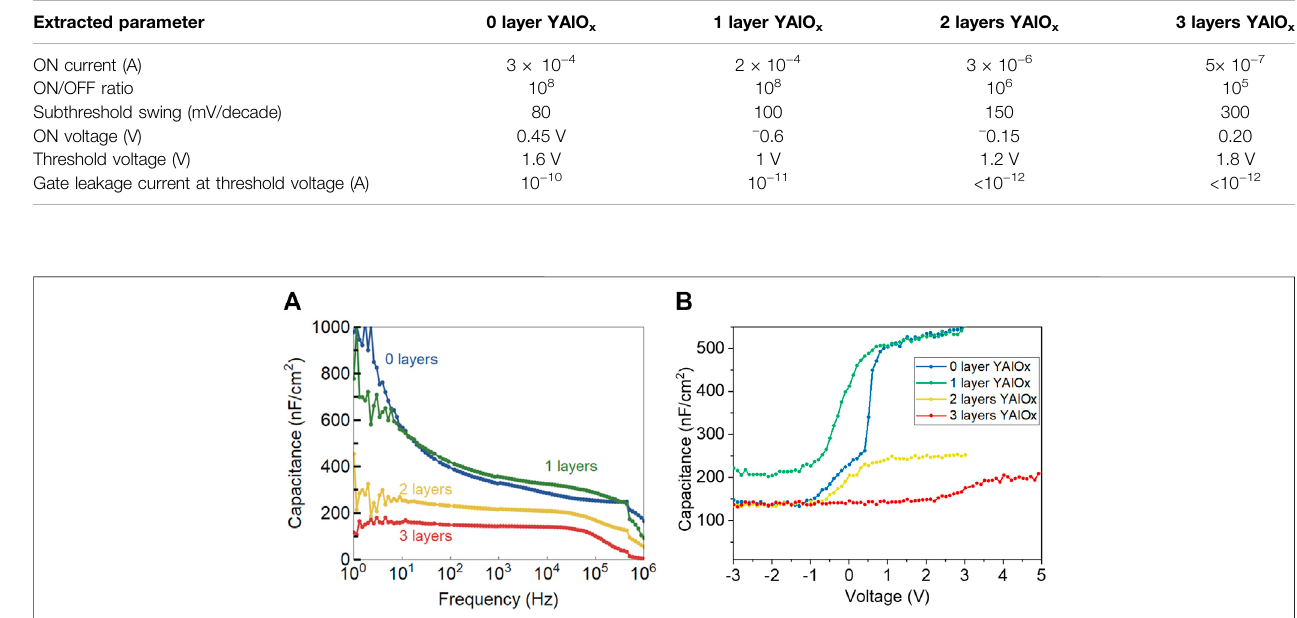
FIGURE 3 | (A) Frequency dispersion of the areal capacitance in the bilayer AlO x /YAlO x dielectrics measured at 3 V. (B) C-V characteristics of the MOS capacitors with bilayer AlO x /YAlO x dielectrics and IZO channel layer.